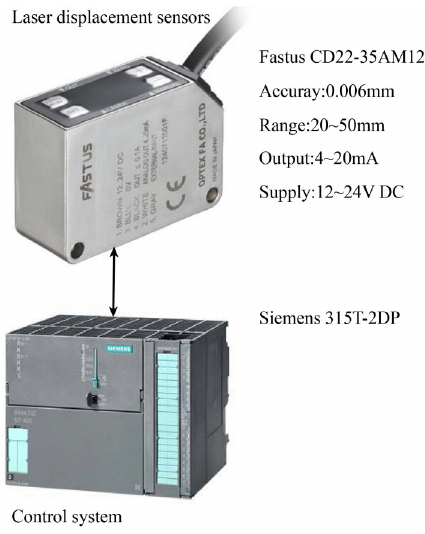
Figure 10. The hard structure of data collect system for laser displacement sensors.